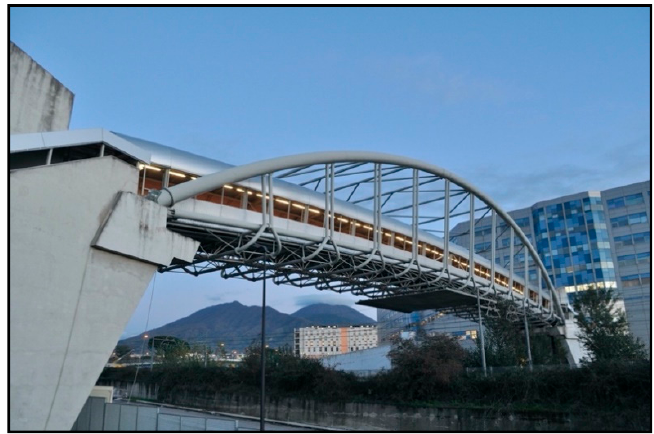
Figure 5. The pedestrian bridge in the “Ospedale del Mare” hospital complex in Naples, Italy.